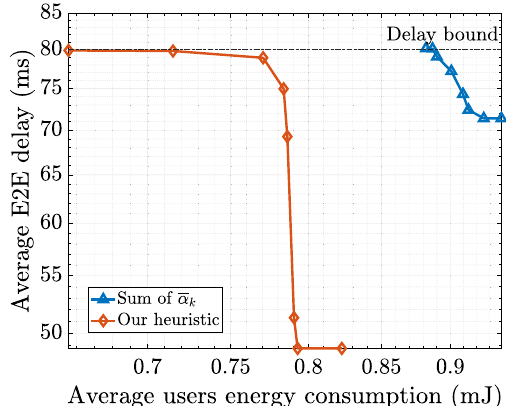
Fig. 5 Average delay vs. users energy for different RIS optimization strategies